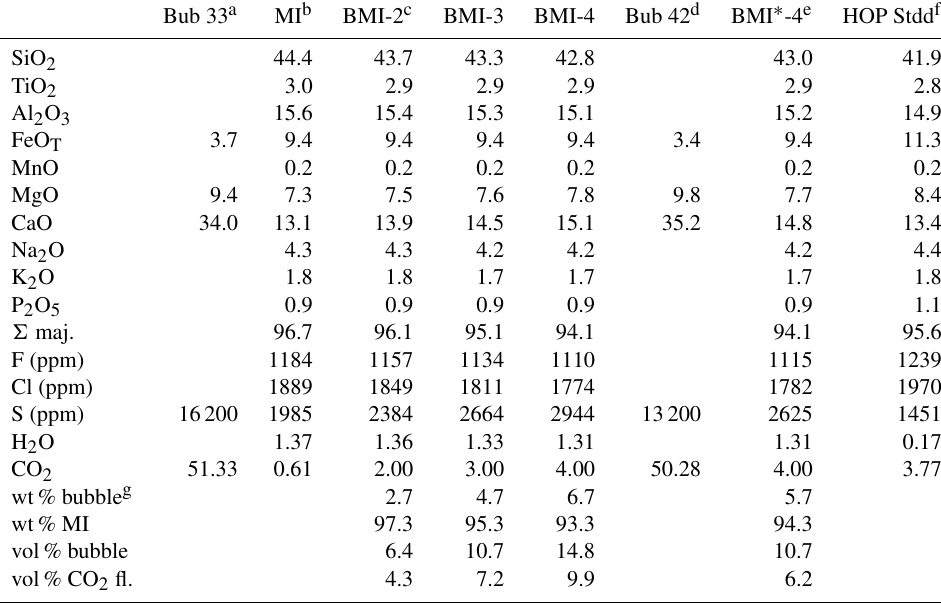
a Bubble composition Bub 33 is based on the masses of carbonate, FeS 2 , and CO 2 fluid reported by Schiavi et al. (2020) in the bubble of a melt inclusion from Thueyts, which contains 33vol% carbonate. For the carbonate phase, we consider a mixture of 70mol% CaCO 3 , 27mol% MgCO 3 , and 3mol% FeCO 3 . b MI is the average glass composition measured in unheated melt inclusions from Thueyts (corrected for PEC). For all the silicate liquids in the table (but not for the bubble), the major and minor elements (SiO 2 to P 2 O 5 ) are normalized to a total of 100%; the total before normalization is given in the line “ (cid:54) maj.” (major). c BMI-2 to BMI-4 are obtained by mixing Bub 33 and MI in different proportions to obtain bulk compositions with 2wt%, 3wt%, or 4wt% CO 2 , respectively. d Bubble composition based on the same data as for Bub 33 but considering 42vol% of carbonates instead of 33vol% to take into account the uncertainty in Raman tomography ( ± 9 vol%; Schiavi et al., 2020). e BMI ∗ -4 is a composition with 4wt% CO 2 obtained by mixing Bub 42 with the average melt inclusion composition MI recalculated with 1.2wt% dissolved CO 2 (see text for explanation). f HOP Stdd is the average composition of melt inclusions homogenized under standard conditions, with all iron recalculated as FeO. g Weight percentages of bubble and silicate glass required to produce the mixtures with 2wt%, 3wt%, and 4wt% CO 2 . The volume percentages of the whole bubble and of CO 2 fluid (fl.) are given for comparison and were computed using a bulk density of 1.15gcm − 3 for Bub 33